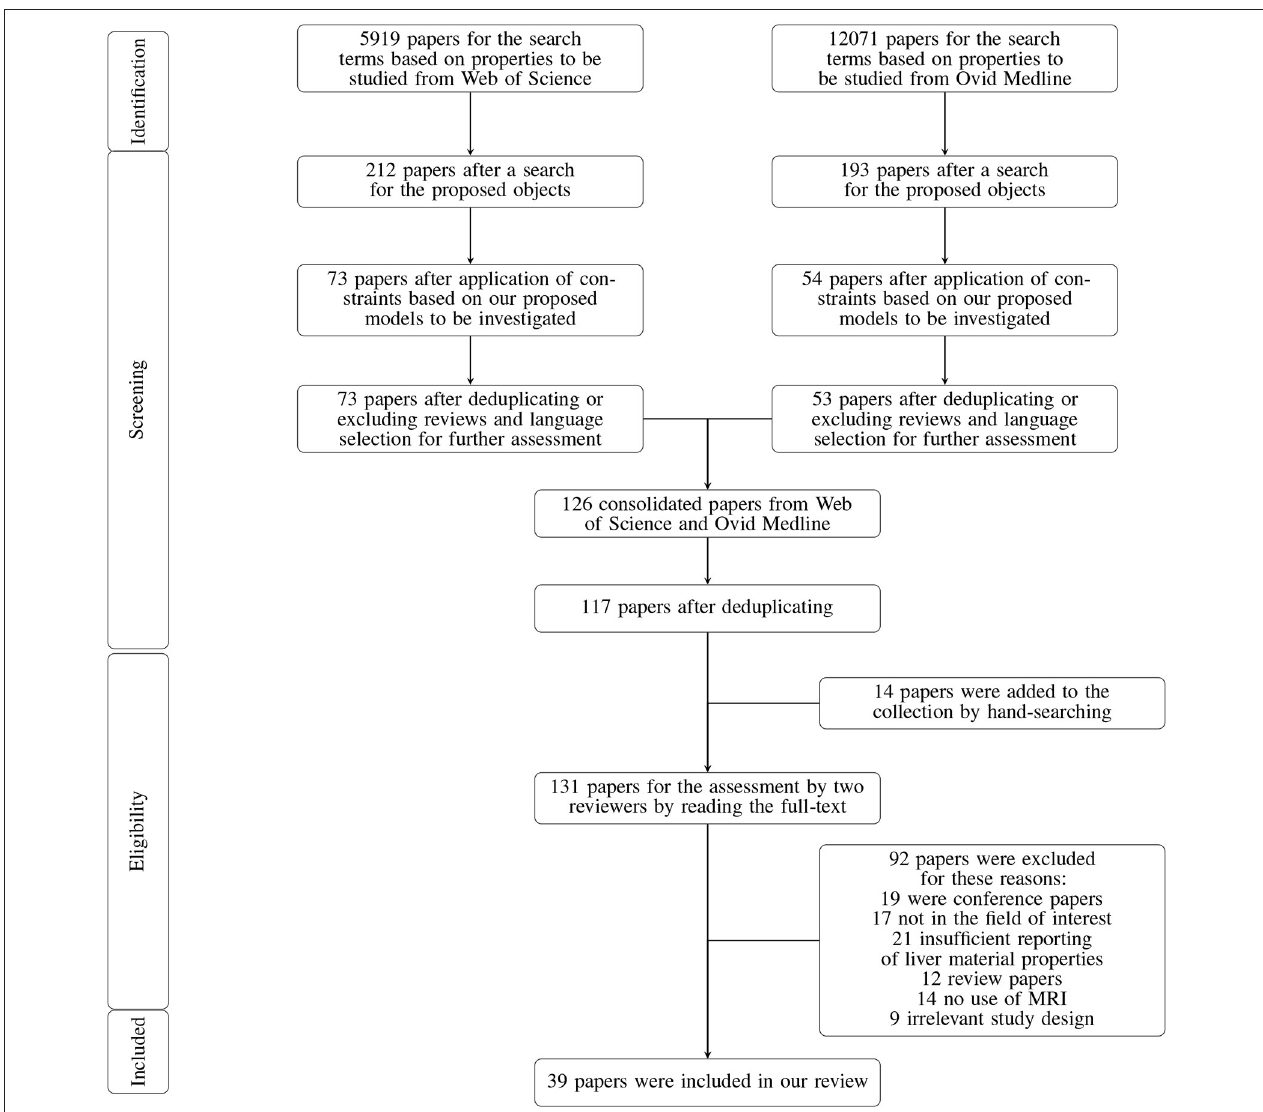
FIGURE 1 | Flowchart of the screening